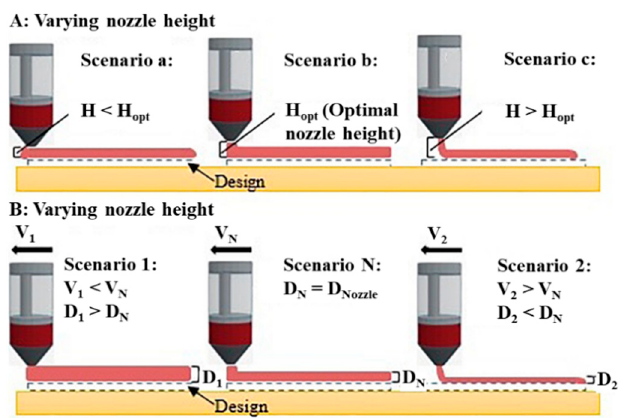
Figure 2. Effect of different nozzle heights ( A ) and different printing speeds ( B ) on streamline accuracy (Reprinted with permission from Dick et al., [20]. © 2019, Elsevier Ltd., Amsterdam, The Netherlands) [20].